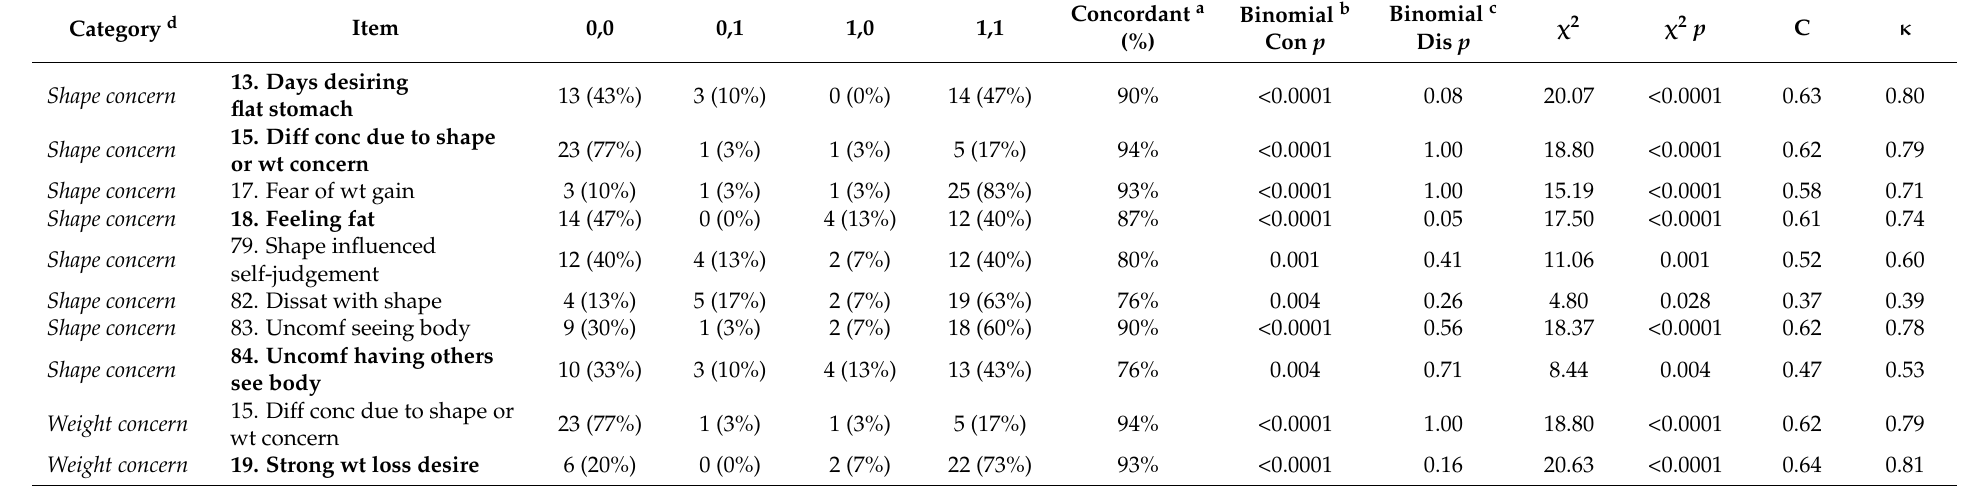
Table 2. Comparison of responses to items in the interview and